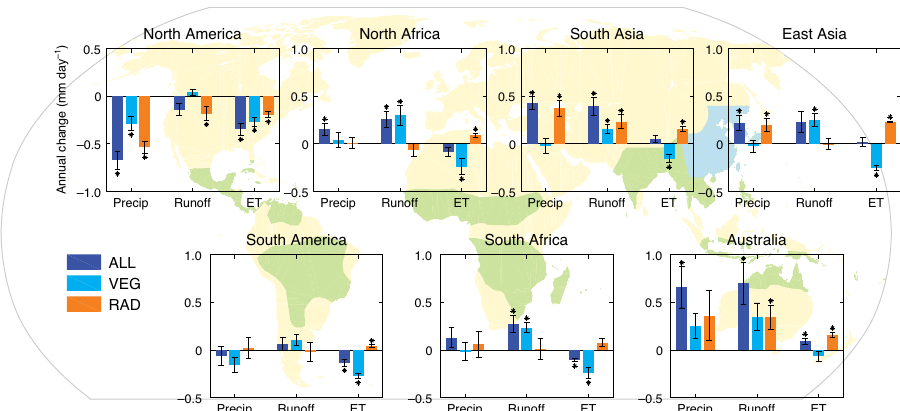
Fig. 1 Annual-mean changes in precipitation (precip), runoff and evapotranspiration (ET) in different simulations. The dark blue, light blue and orange bars indicate the predictions from all CO 2 -based forcings (ALL), physiological only (VEG) and radiative only (RAD), respectively, on hydrological impacts and in each monsoon region as labelled. The bars are model mean, and the error bars (thin lines) indicate standard errors of the mean of the four ESMs analysed. Changes are quanti fi ed by the differences of the model years 121 – 140 (~4 × CO 2 -enriched), and the years 1 – 20 (historical; see Methods section). Asterisks indicate that the change is signi fi cant for the four ESMs ( P < 0.05, t -test), and so the latter test is based on the standard errors to assess if there is a mean change. Regional monsoon domains are shown in light green colours on the background map, while East Asia is in light blue in order to distinguish it from South